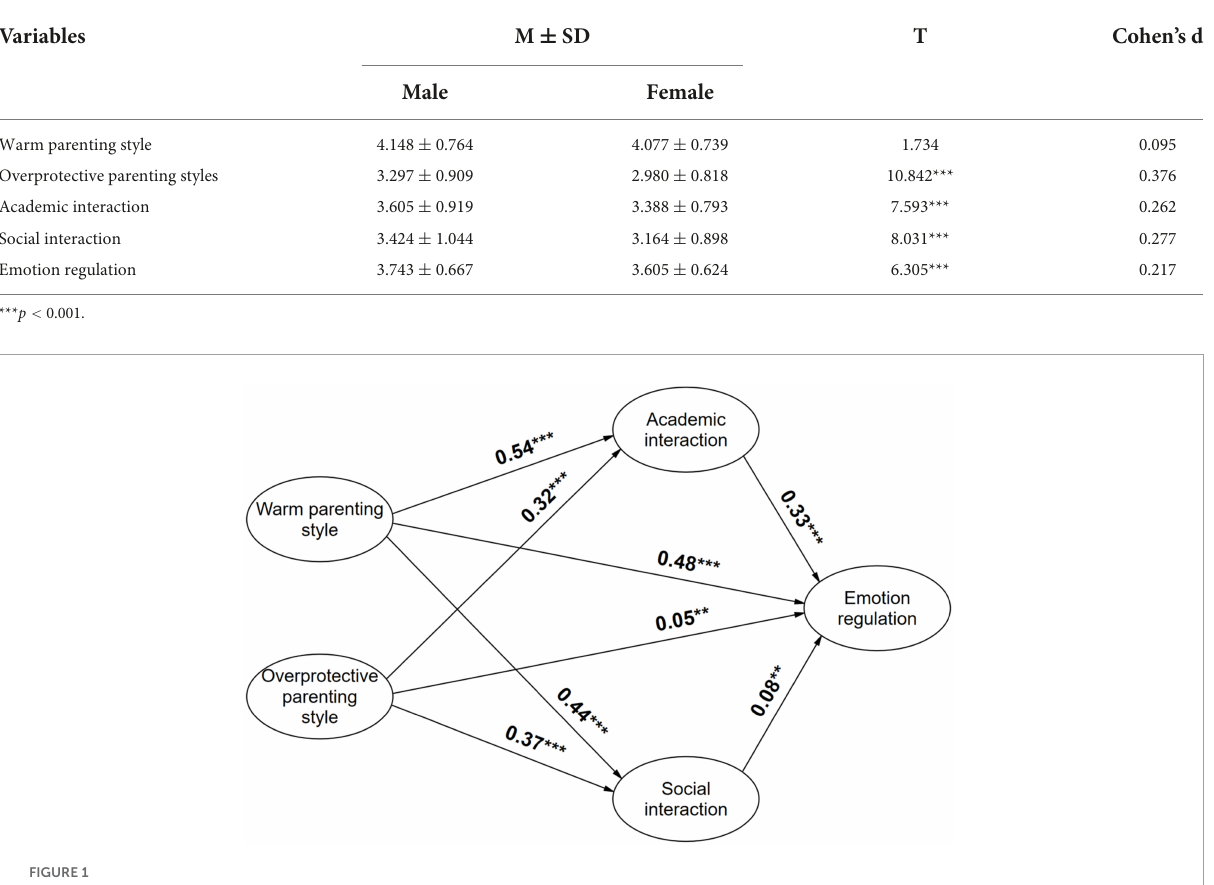
regulation of undergraduate students is only 10% of the effect of warm family